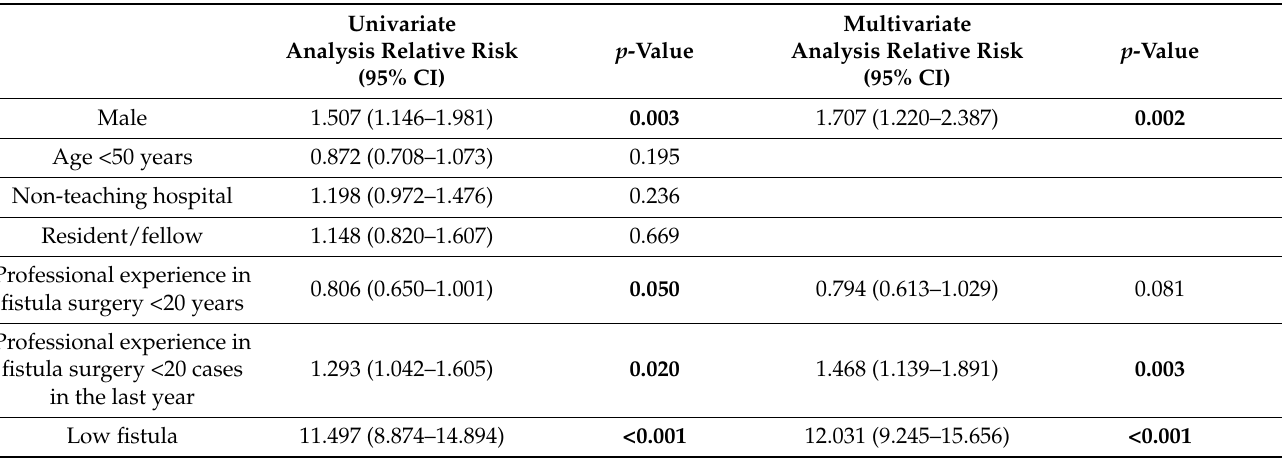
Table 3. Univariate and multivariate analyses evaluating factors related to the acceptance of fistu- lotomy in both low and high fistula (binary logistic regression model). The p -value in bold was statistically